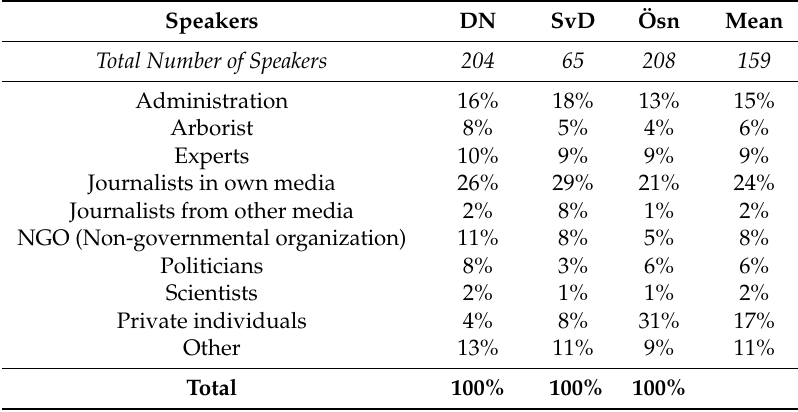
Table 3. Total number of speakers in the newspapers DN, SvD, and Ösn and percentage distribution in different speaker groups. Speakers